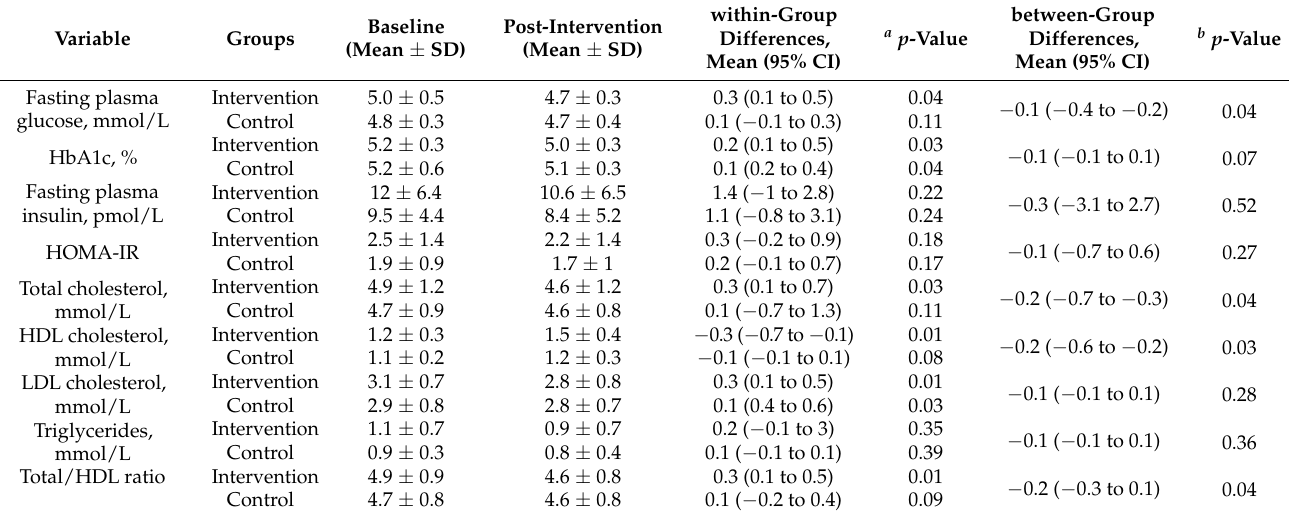
Table 7. Metabolic parameters at baseline and